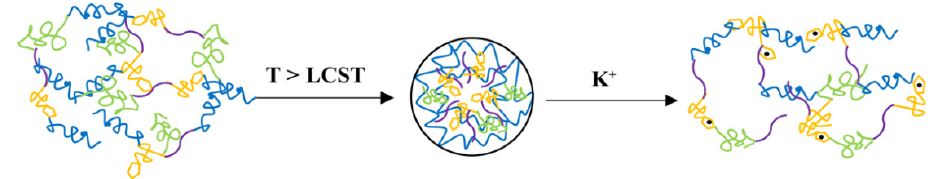
9 of 16 Figure 3. The UV − vis transmittance curves of PLENB changed with temperature in KCl solution ( A ); the LCST of PLENB in different ion solution ( B ); the transmittance curves of PLENB1 ( C ), PLENB2 ( D ), PLENB3 ( E ), and the LCST curves ( F ) of PLENB with different K + concentration in different temperature. Subsequently, we found that the LCST of PLENB1, PLENB2 and PLENB3